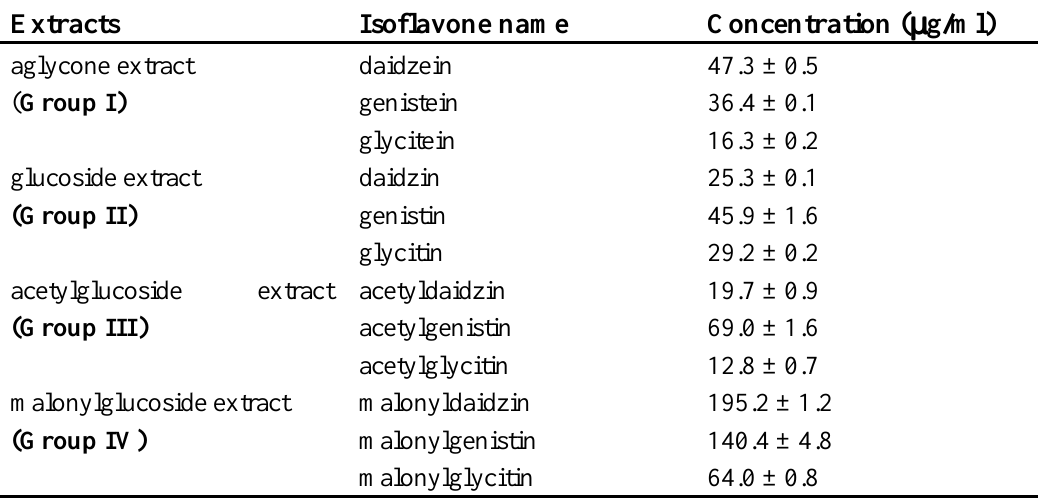
Table 1. Contents in group I~IV isoflavone extracts from